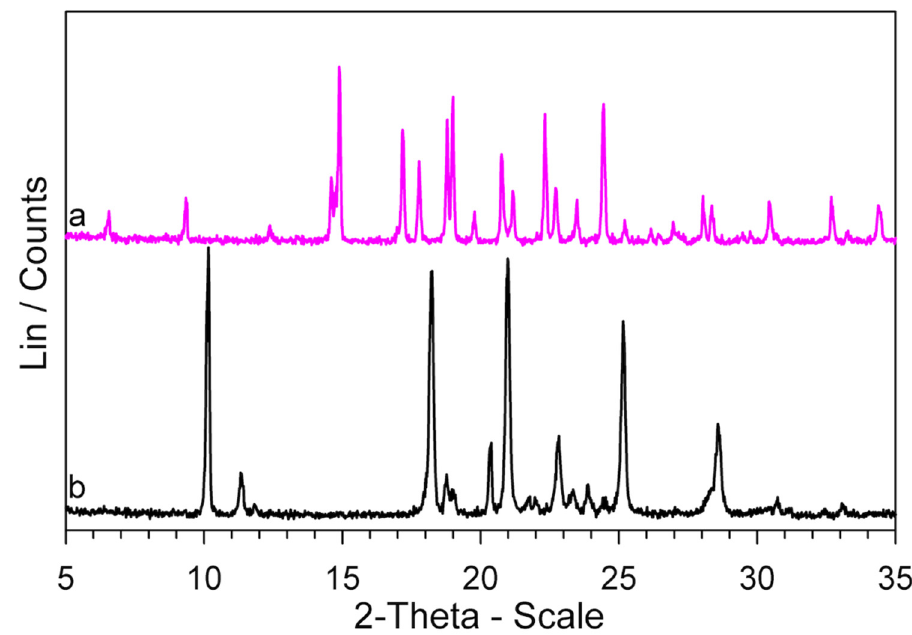
Figure 8. XRPD patterns of GS ( a ) and GS* ( b ) samples. Table 4. Main peaks/bands of FT-IR spectra of GS and GS* (b)